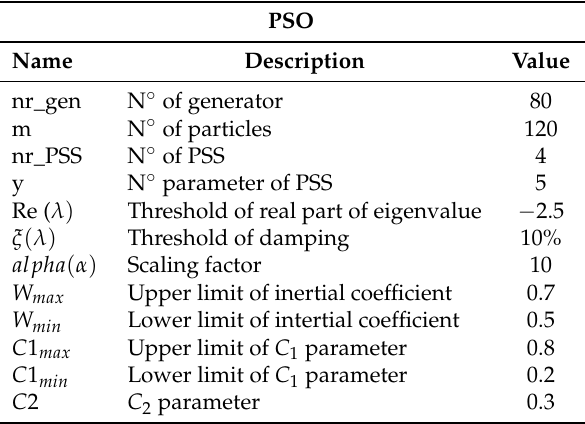
Table 3. Variables of PSS for system II.